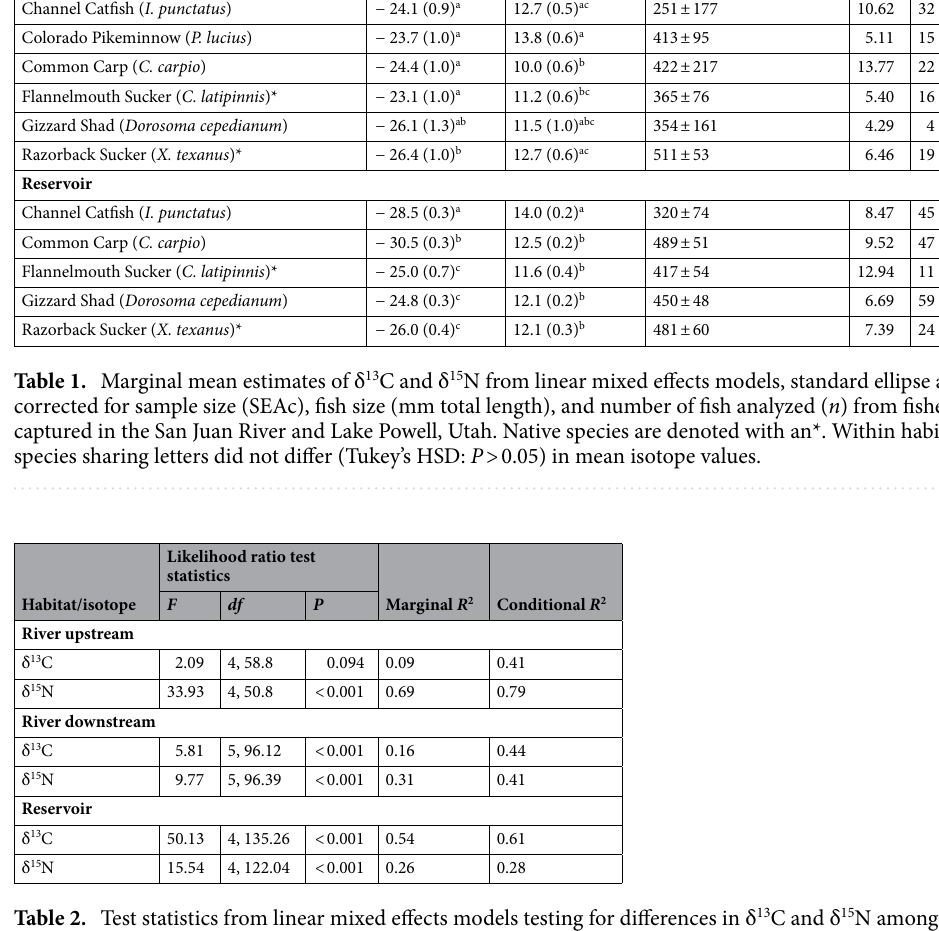
Table 2. Test statistics from linear mixed effects models testing for differences in δ 13 C and δ 15 N among species within habitats. Mixed effects models included a random effect of